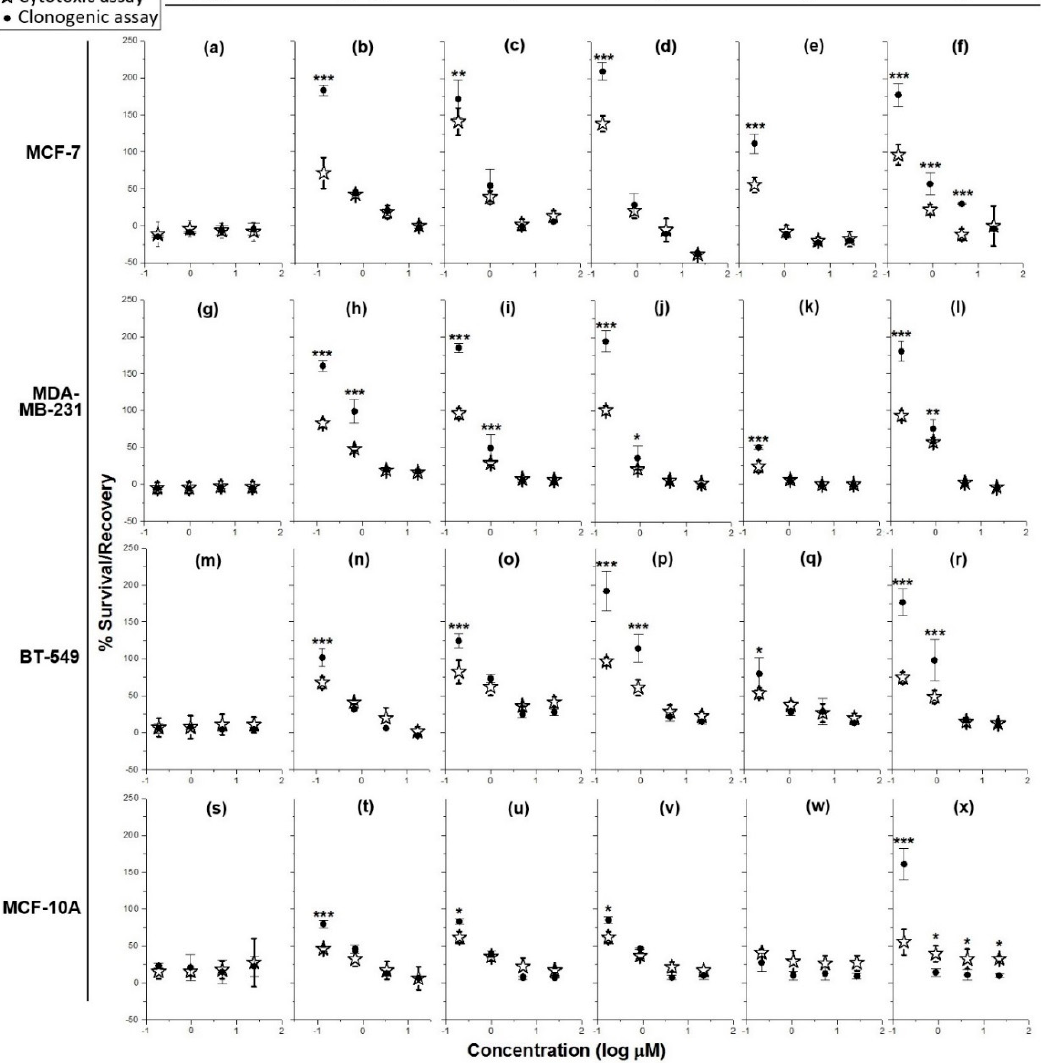
Figure 2. Graphs showing cell survival rates in cytotoxic assay after 72 h of treatment ( ✰ ) with controls (POD and VP-16) and lignans (compounds 1 – 4 ), and recovery rates in clonogenic assay ( ● ) (cytocidal and/or cytostatic activity) after 72 h post-treatment against four cell lines: MCF-7 ( a – f ), MDA-MB-231 ( g – l ), BT-549 ( m – r ), and MCF-10A ( s – x ) ( n = 3). Percentages of survival and recovery were compared with a one-way ANOVA and Bonferroni correction (* = p < 0.05, ** = p < 0.01, and *** = p < 0.001).